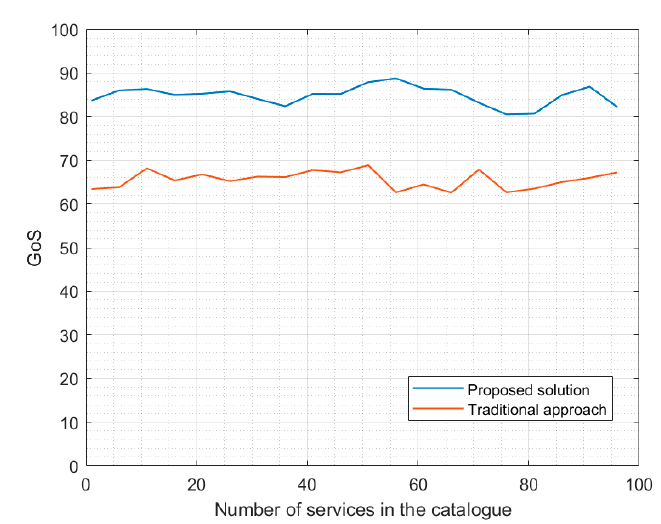
Figure 7. First experiment: Grade of Service (GoS).